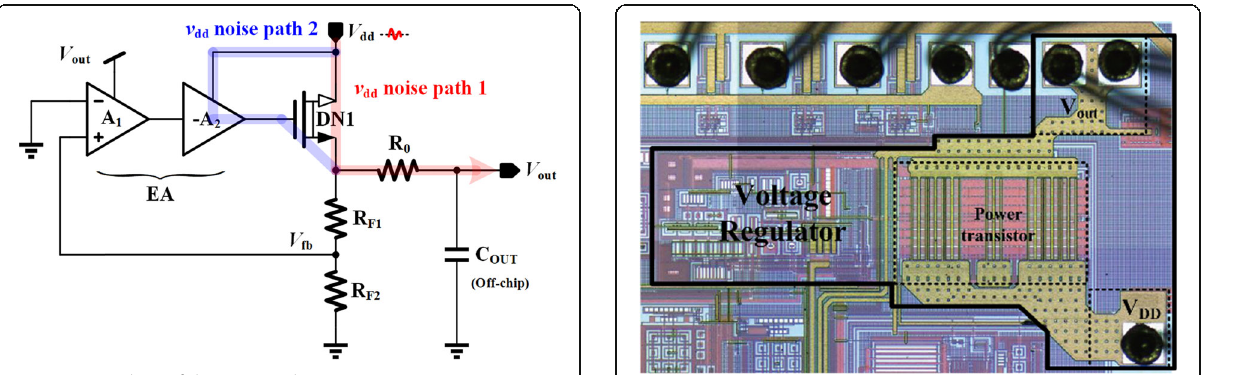
Fig. 9 The chip photo of proposed VR